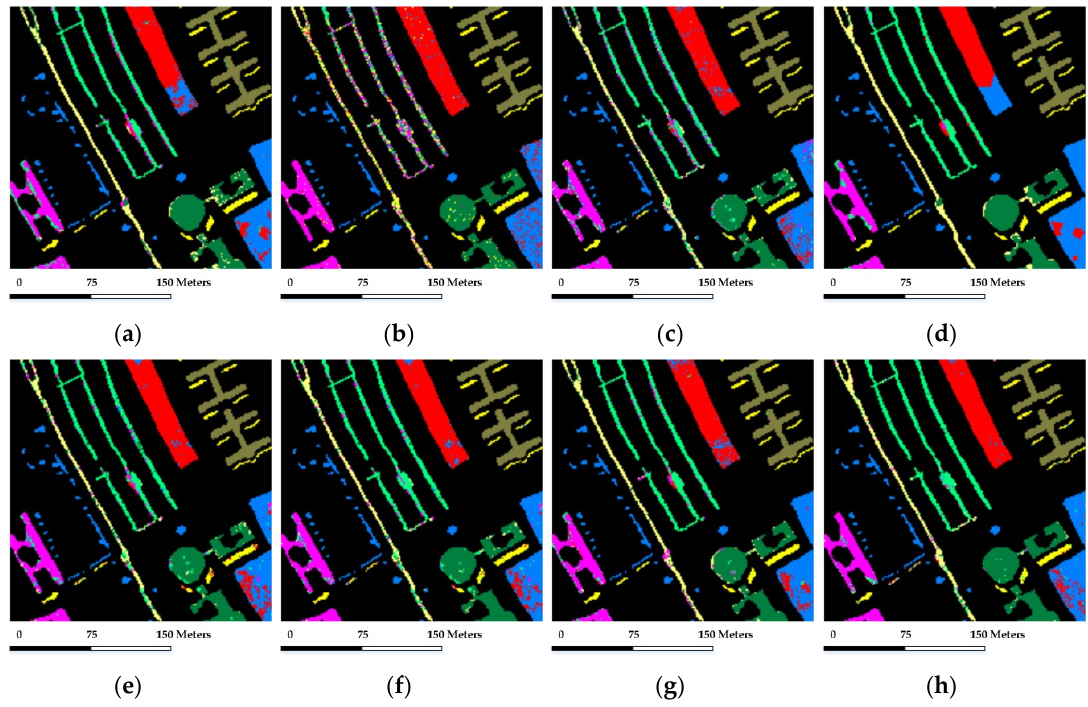
Figure 10. Classification maps obtained by the different tested method for the University of Pavia scene (OA are in parentheses): ( a ) SVM (86.73%); ( b ) CRC (79.17%); ( c ) SRC (86.58%); ( d ) SVM-MRF (90.33%); ( e ) JSRC (88.54%); ( f ) GSRC (90.71%); ( g ) NL-SRC (91.31%); ( h ) NSLS-GSRC (93.27%). Table 5. Classification accuracies (in percent) obtained by the different tested methods for the ROSIS University of Pavia scene. In all cases, 270 labeled samples in total (30 samples per class) were used for training. The best results are in bold.